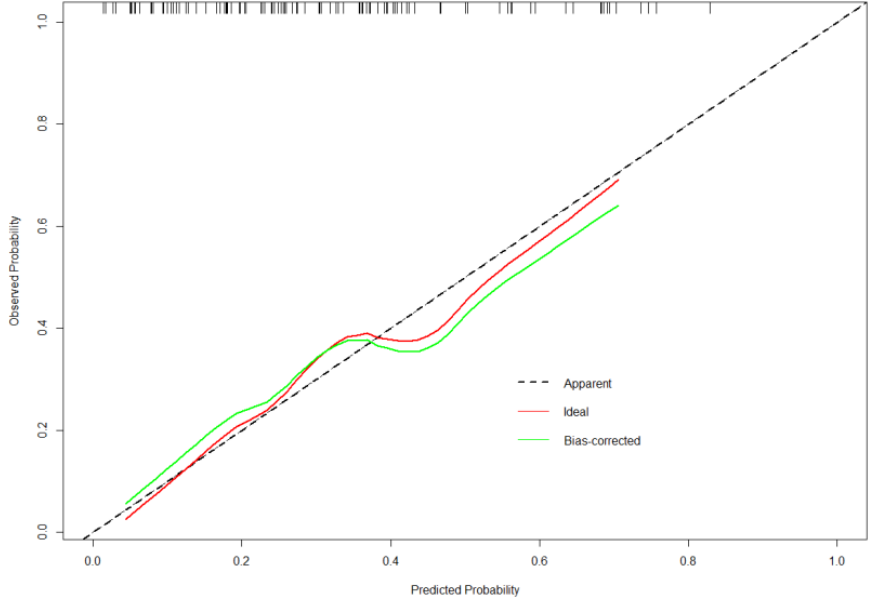
Figure 5. Calibration curve of the model. The calibration of the model is in line with the agreement between predicted and observed outcomes of improvement of the HAMA score.